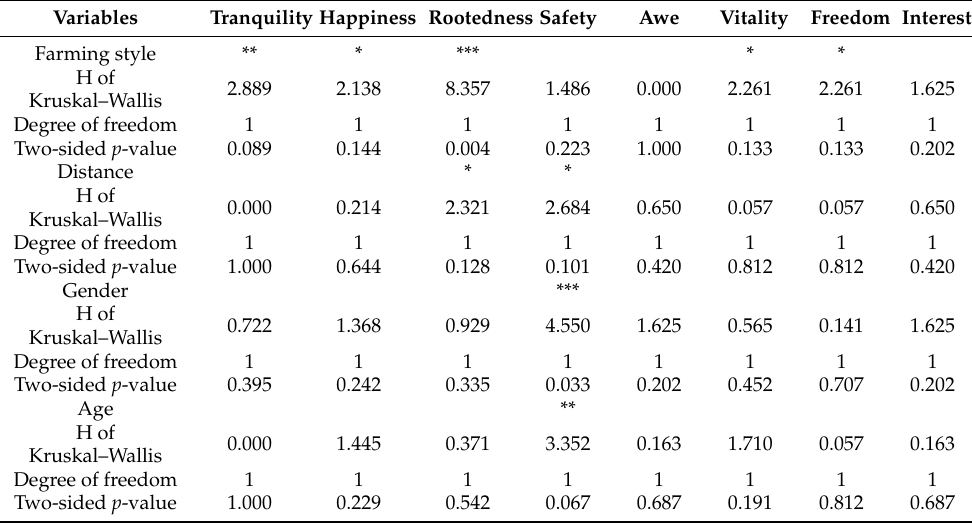
Table 2. Variables that influence the different types of senses on the